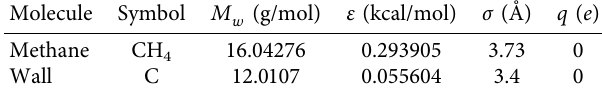
Table 1: TraPPE-UA potential parameters